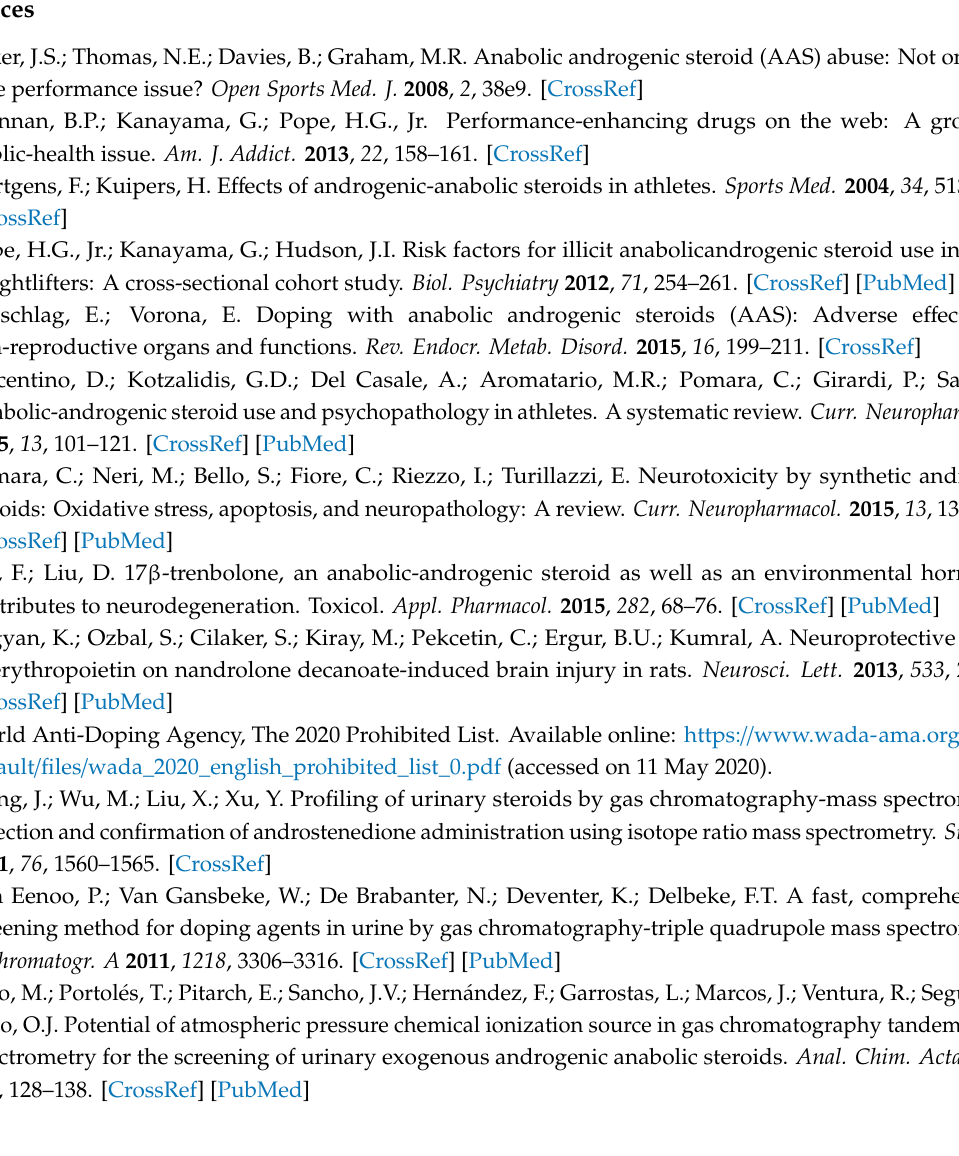
VAMS, Figure S2: Surface response graph for the microwave drying time assay of DUS, Figure S3: Forced drying time assay of VAMS, Figure S4: Extraction yield and purification assay results: extraction solvent comparison, Figure S5: Extraction yield and purification assay results: extraction means comparison. MAE, microwave-assisted extraction; UAE, ultrasound-assisted extraction, Table S1: Performance comparison of existing methods with the proposed method for anabolic steroid analysis, Table S2: Passing-Bablok regression